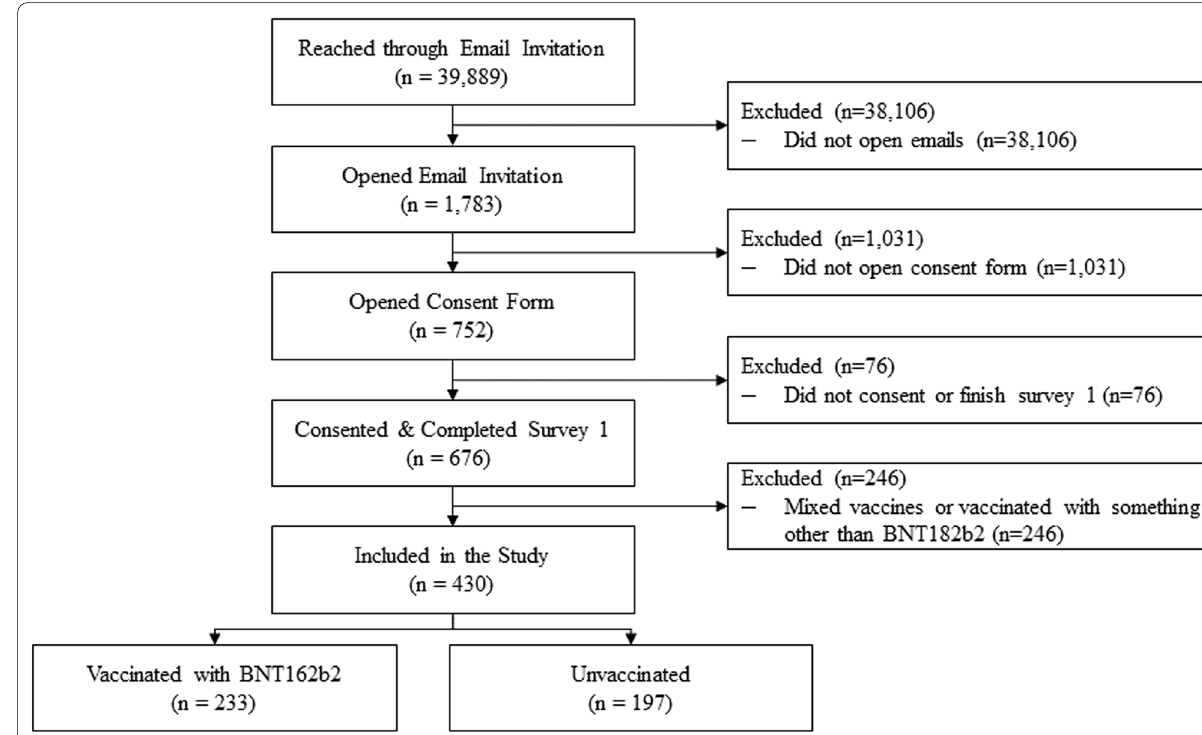
Fig. 2 Study flow